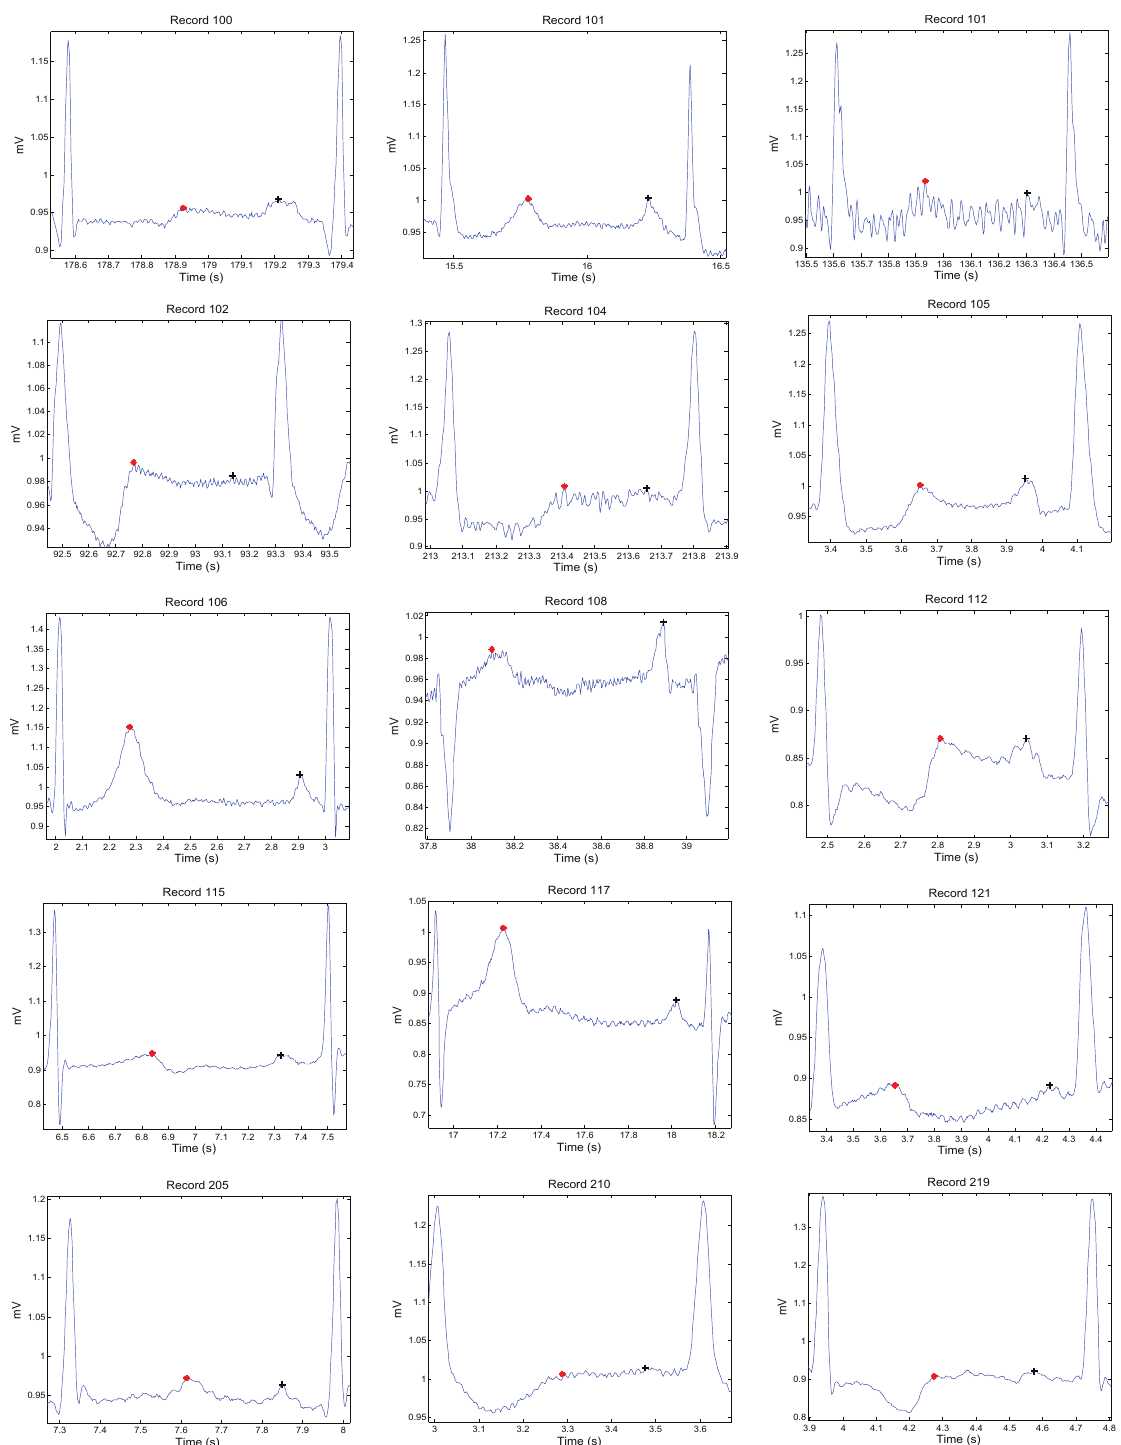
Figure 1. Annotation of P and T waves in normal beats. Here, “+” represents the P wave and “*” represents the T wave. Note that the higher peaks represent the QRS